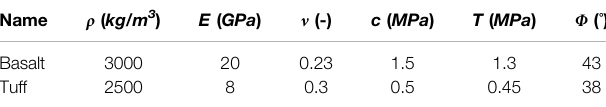
TABLE 2 | Parameters of block elements in the numerical